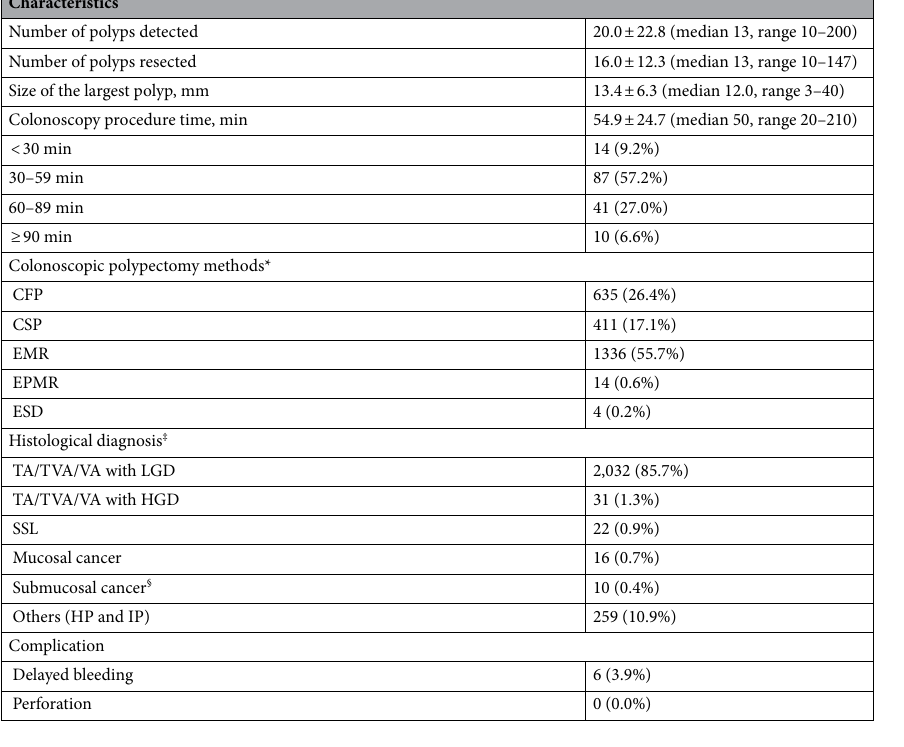
Table 2. Baseline colonoscopy findings. Data are presented as n (%) or mean ± standard deviation with median and range. CFP cold forceps polypectomy, CSP cold snare polypectomy, EMR endoscopic mucosal resection, EPMR endoscopic piecemeal mucosal resection, ESD endoscopic submucosal dissection, HGD high- grade dysplasia, LGD low-grade dysplasia, SSL sessile serrated lesion, TA tubular adenoma, TVA